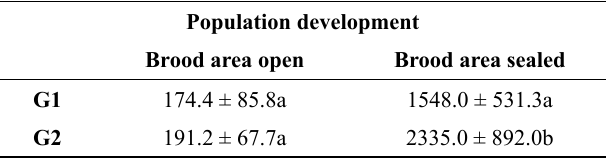
Table 1 . Open and sealed brood area (cm 2 ) of honeybees Apis mellifera Africanized supplemented or not with 25% of crude protein.